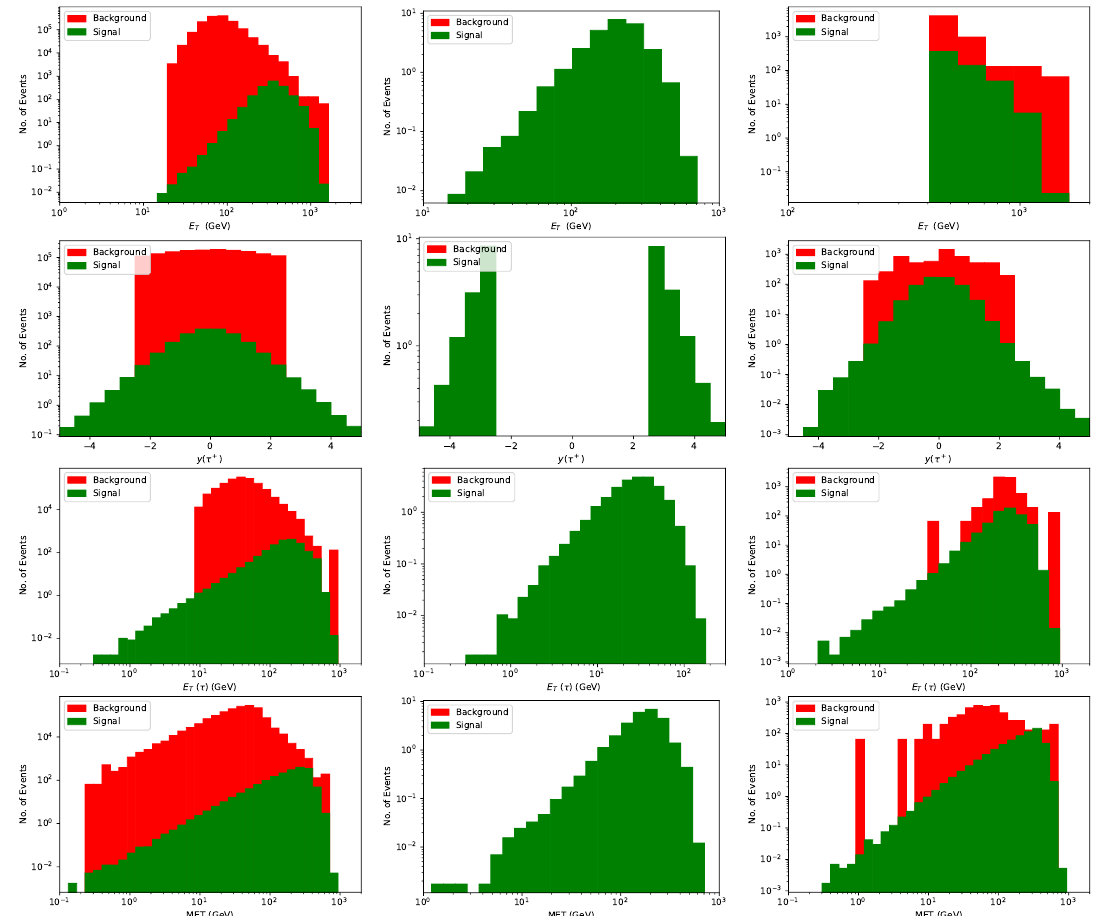
Figure 8 . Parton level event distributions for pp → H + an integrated luminosity of 3000 fb − 1 along with the SM background (in red). (Left column, top to bottom): the total transverse energy E T , The rapidity y , the total transverse energy of the τ + lepton, E T ( τ + ) , and the missing transverse energy /E the same distributions after the selection criteria of | y | > 2 . 5 , which eliminates the background. (Right column, top to bottom): the same distribution, after imposing the cut E T > 400